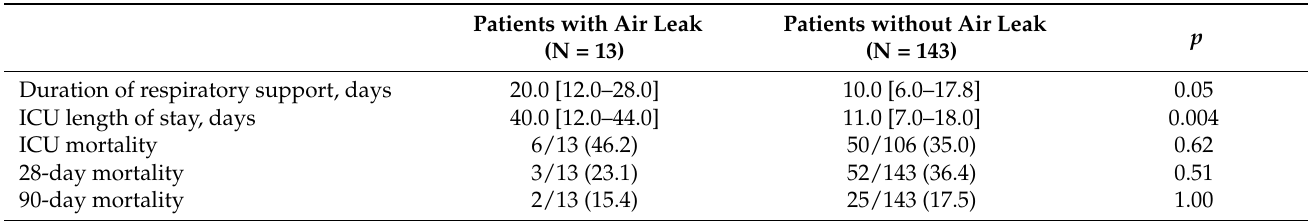
Table 3. Clinical Outcomes of Patients Categorized According to Presence of Air